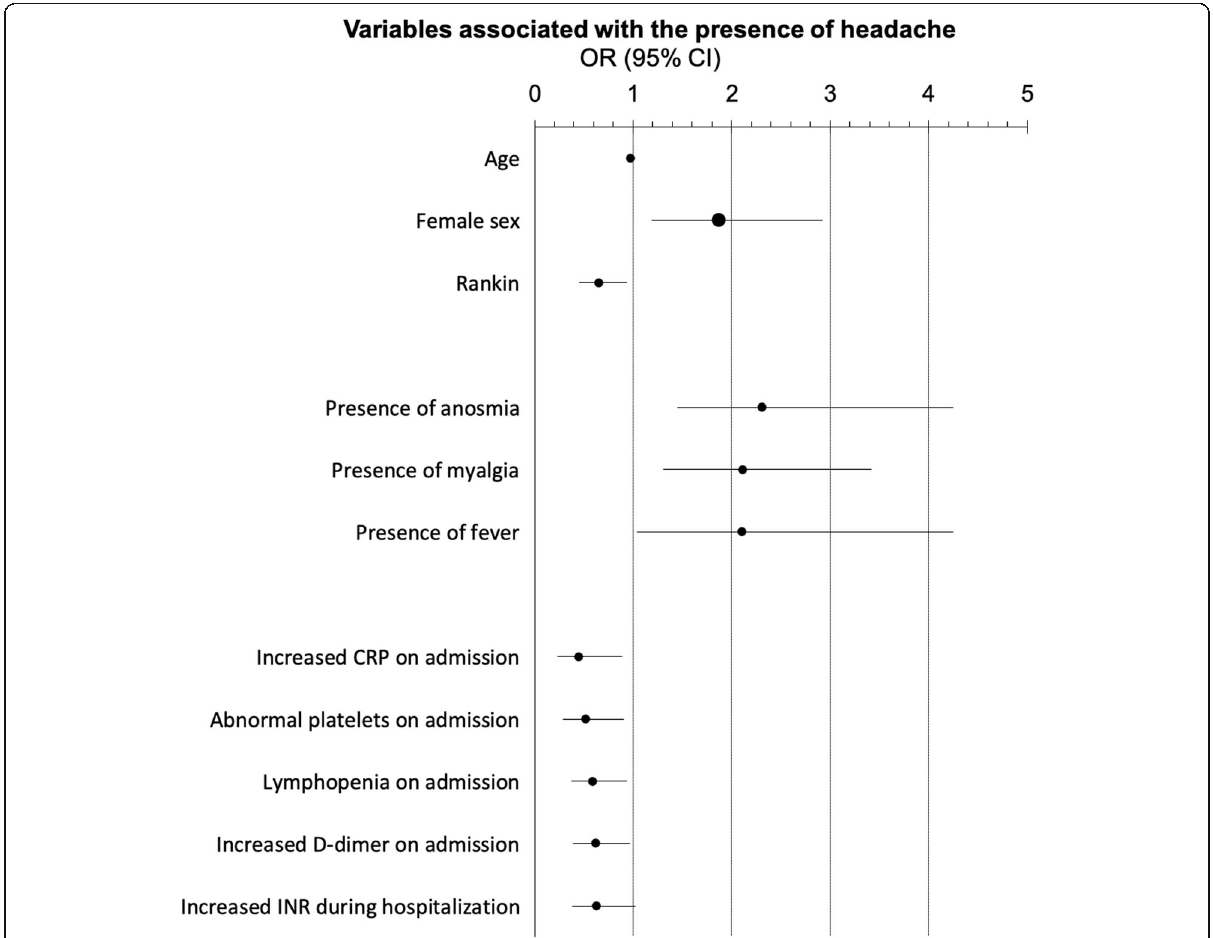
Fig. 1 Odds ratio and 95% confidence interval of variables associated with the presence of